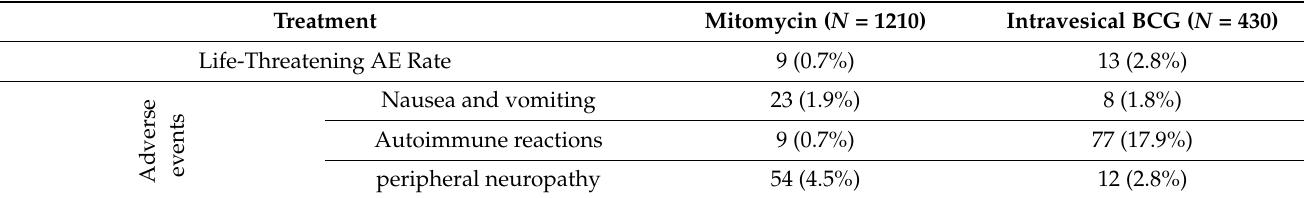
Table 7. AE results of a RCT that compares the intravesical BCG treatment to mitomycin treatment. Treatment Life-Threatening AE